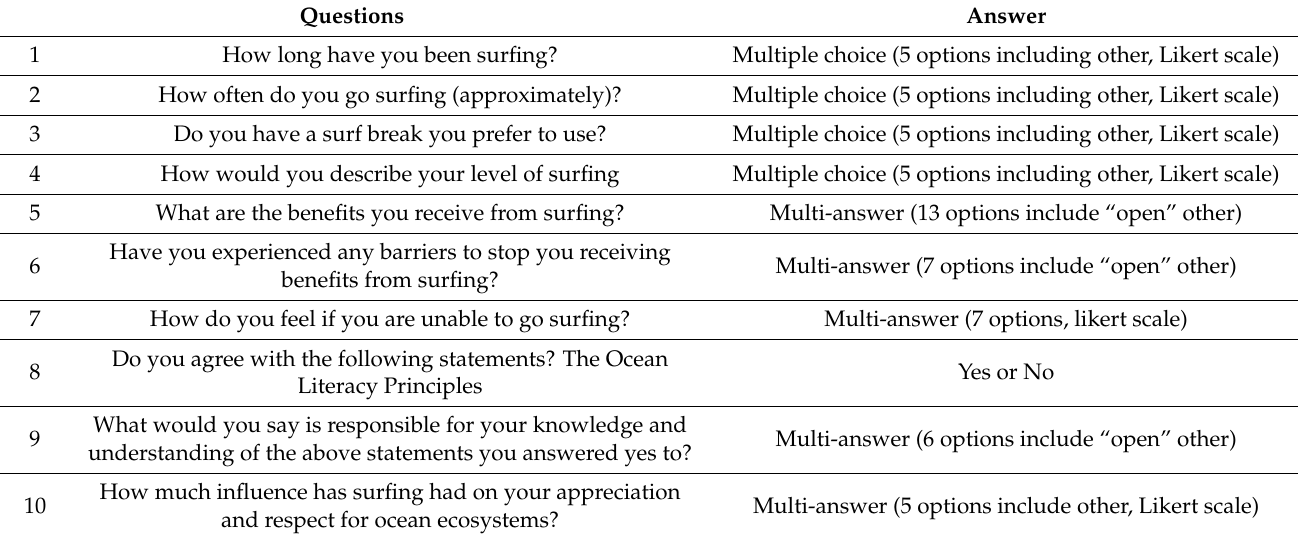
Table A1. Anonymised survey